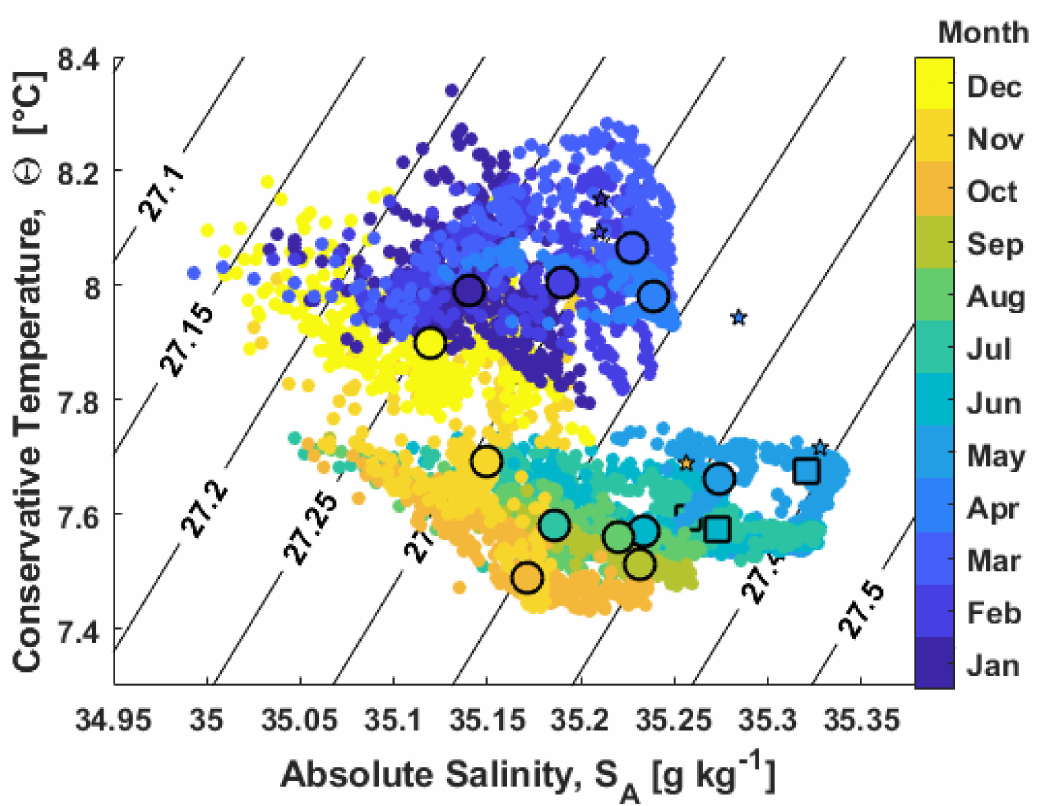
Figure 3. Bottom water Θ , S A -values at Nakken bank reef. Months are color coded. The larger circles (SLM) and squares (MLM) mark the monthly median values, and stars show the cruise CTD cast median values for 205–215 m